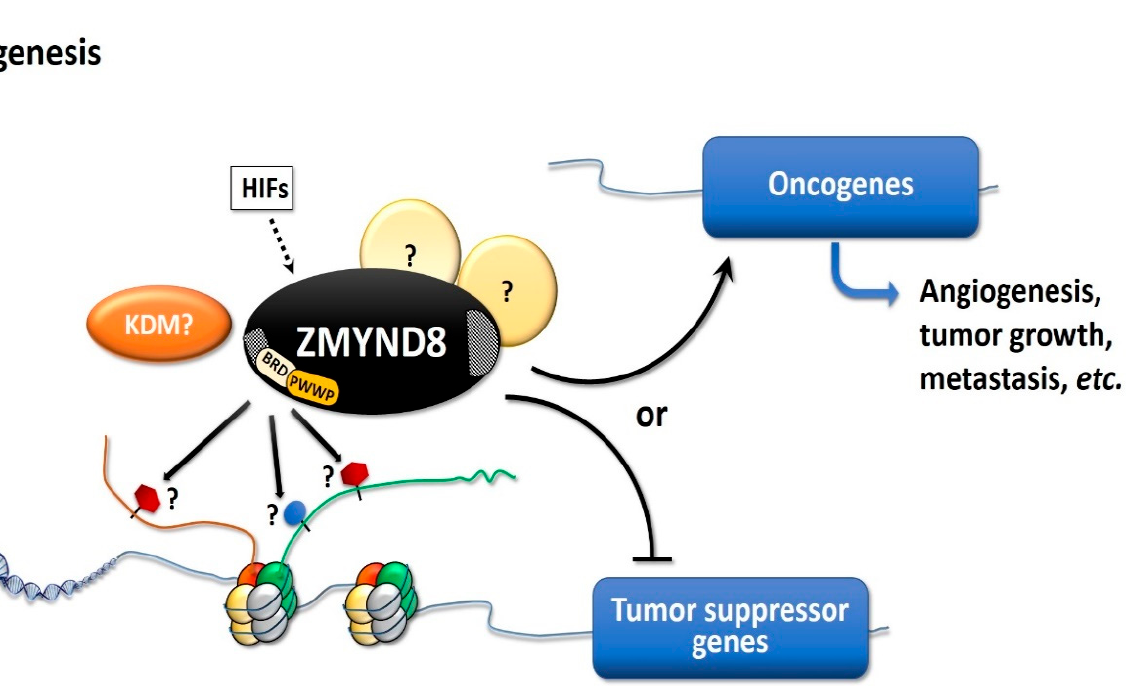
Figure 4. Diagram showing the possible mechanisms of the pro-oncogenic effects of ZMYND8. ZMYND8 can be activated by HIFs and induces angiogenesis, cellular proliferation, and tumor growth. The pro-oncogenic pathways of ZMYND8 are still unclarified. ZMYND8 may cooperate with demethylase, recognize the histone marks, suppress the transcription of tumor suppressor genes, or activate oncogenes, to enhance the tumorigenesis. HIFs: Hypoxia-inducible factors; KDM: Lysine demethylase.